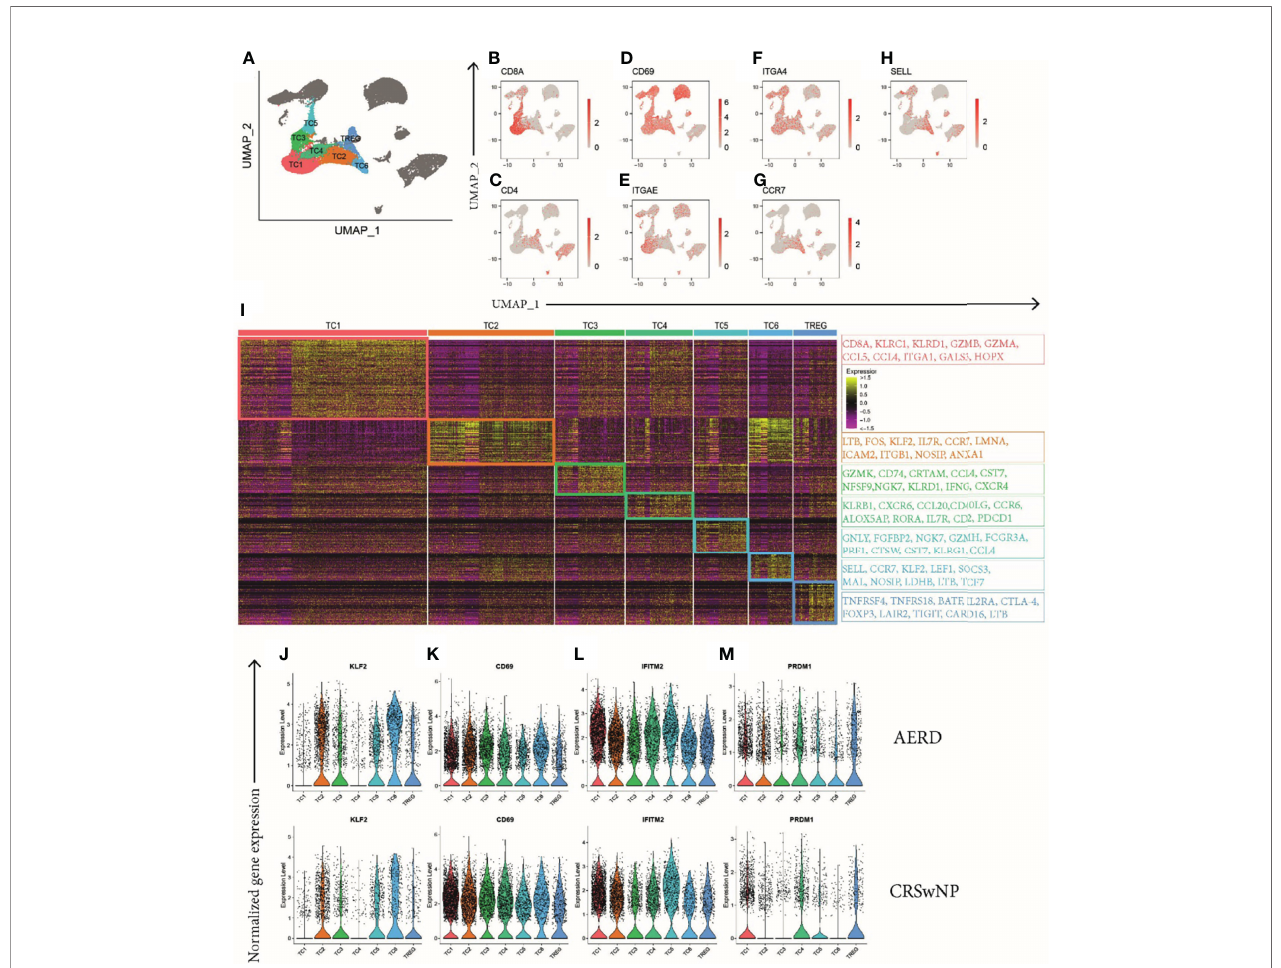
FIGURE 6 | Identi fi cation of T-cell clusters in patients with AERD and CRSwNP. (A) Color-coded UMAP plot showing seven scRNA-seq TC subclusters with (B – H) corresponding feature plots identifying combined natural log-transformed normalized expression of (B) CD8A , (C) CD4 , (D) CD69 , (E) ITGAE , (F) ITGA4 , (G) CCR7 , and (H) SELL . Red color displays intensity levels of natural log-transformed gene expression. (I) Heat map showing z-score of the expression across clusters with selected top color-coded DEG highlighted in boxes characterizing TC cluster identity. (J – M) Color-coded violin plots showing natural log-transformed normalized gene expression for selected DEG in all TC clusters of (top) AERD as compared to (bottom) CRSwNP. AERD, aspirin-exacerbated respiratory disease; CRSwNP, chronic rhinosinusitis with nasal polyps; TC, T cell; DEG, differentially expressed genes; UMAP, Uniform Manifold Approximation and Projection; scRNA-seq, single- cell RNA